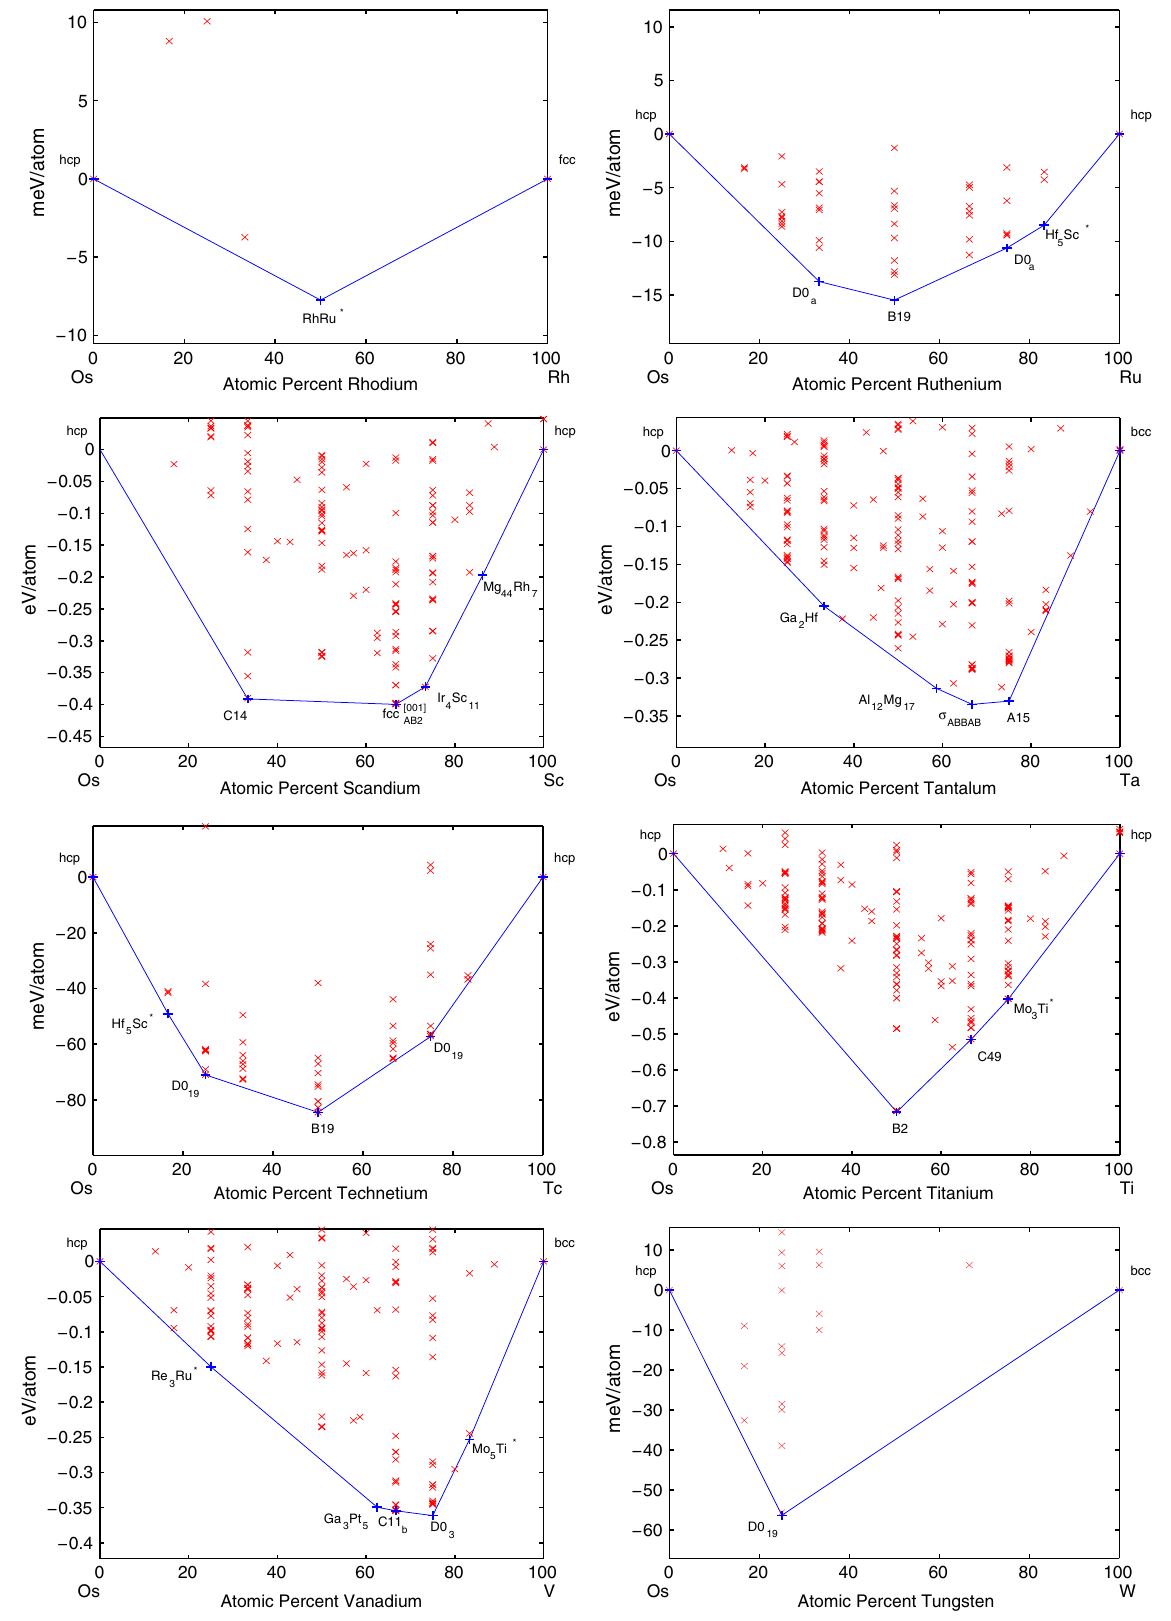
FIG. 13. Convex hulls for the systems Os-Rh, Os-Ru, Os-Sc, Os-Ta, Os-Tc, Os-Ti, Os-V, and